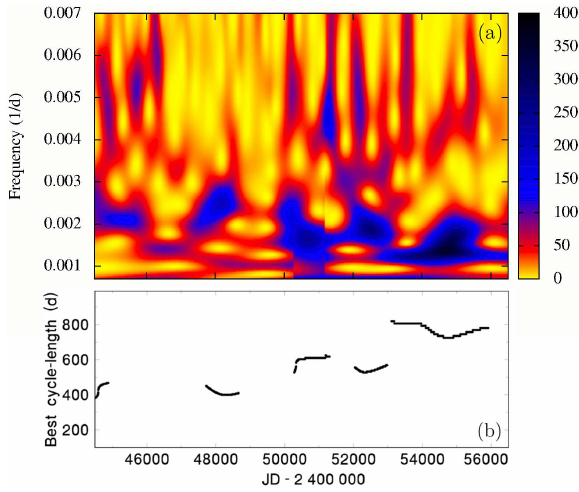
Figure 2: (a) WWZ-transform of the light curve of AM Her from Fig. 1a. (b) The best cycle-length. See Sect. 2 for